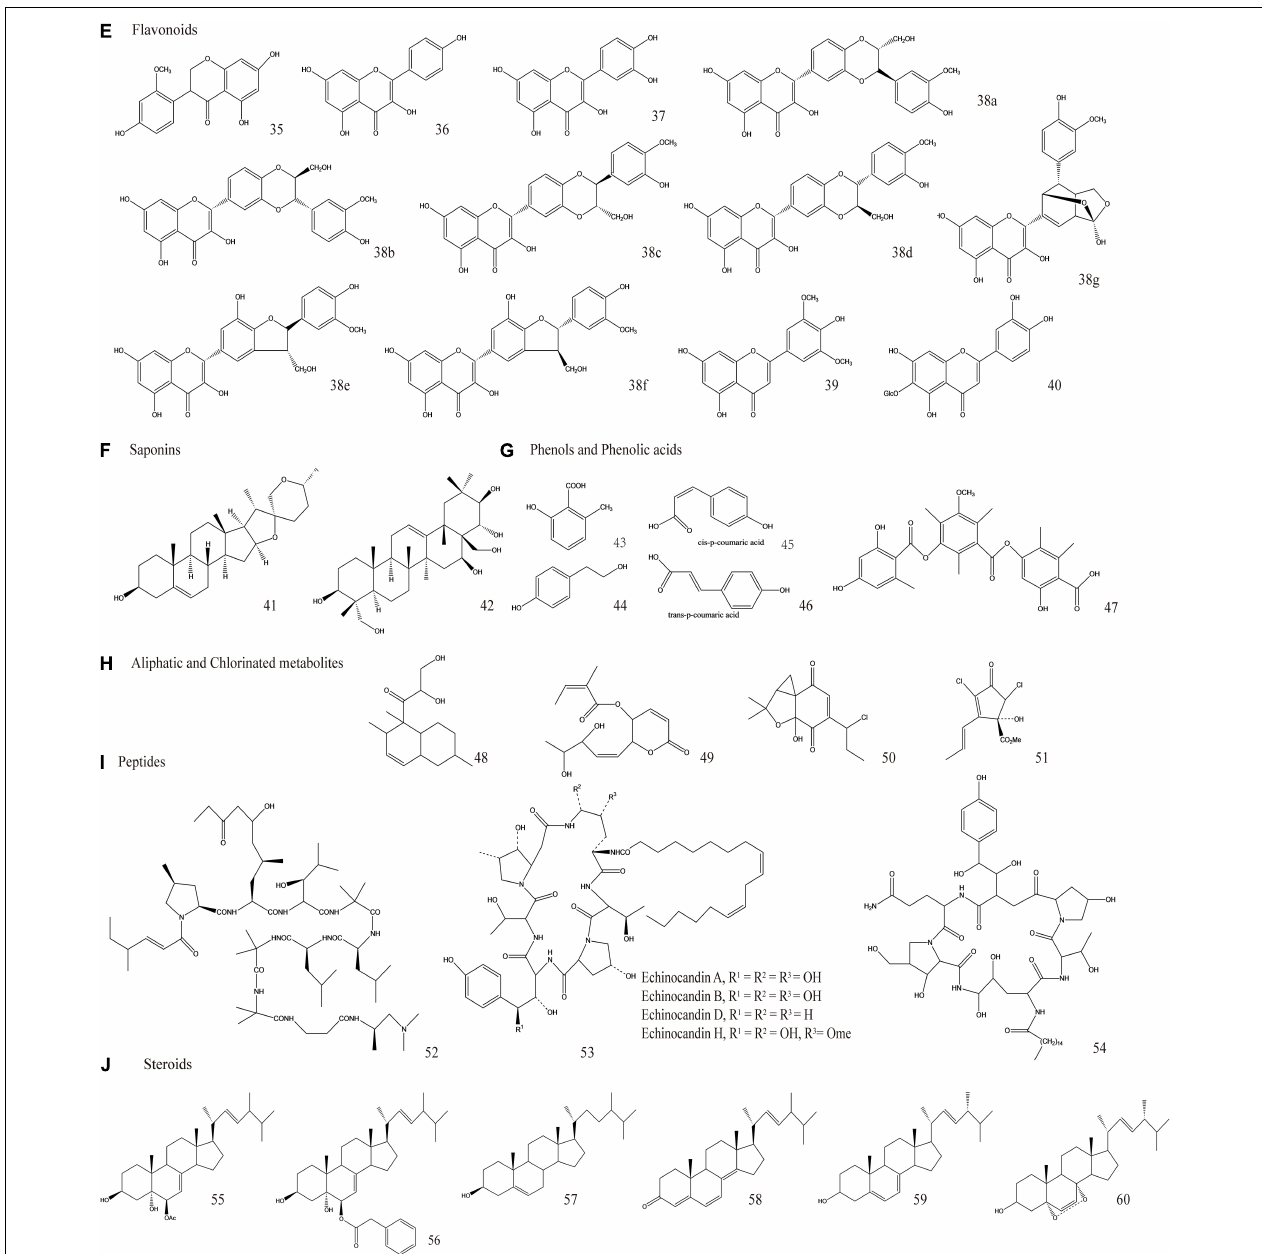
FIGURE 4 | Molecular structures of some typical secondary metabolites (SMs). The classes, subclasses, compounds with references, endophytic fungal sources, together with their potential biological properties of the SMs are briefed in Table 5